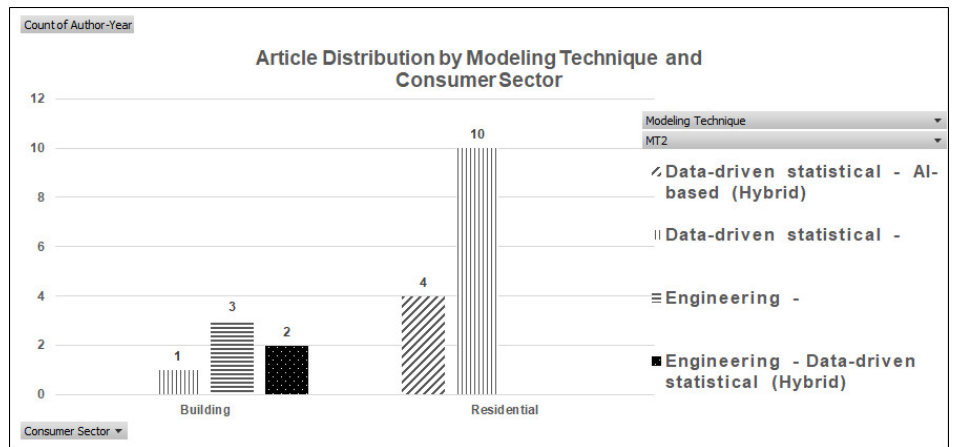
Figure 5. Distribution graph of number of articles by Modeling Technique. Residential